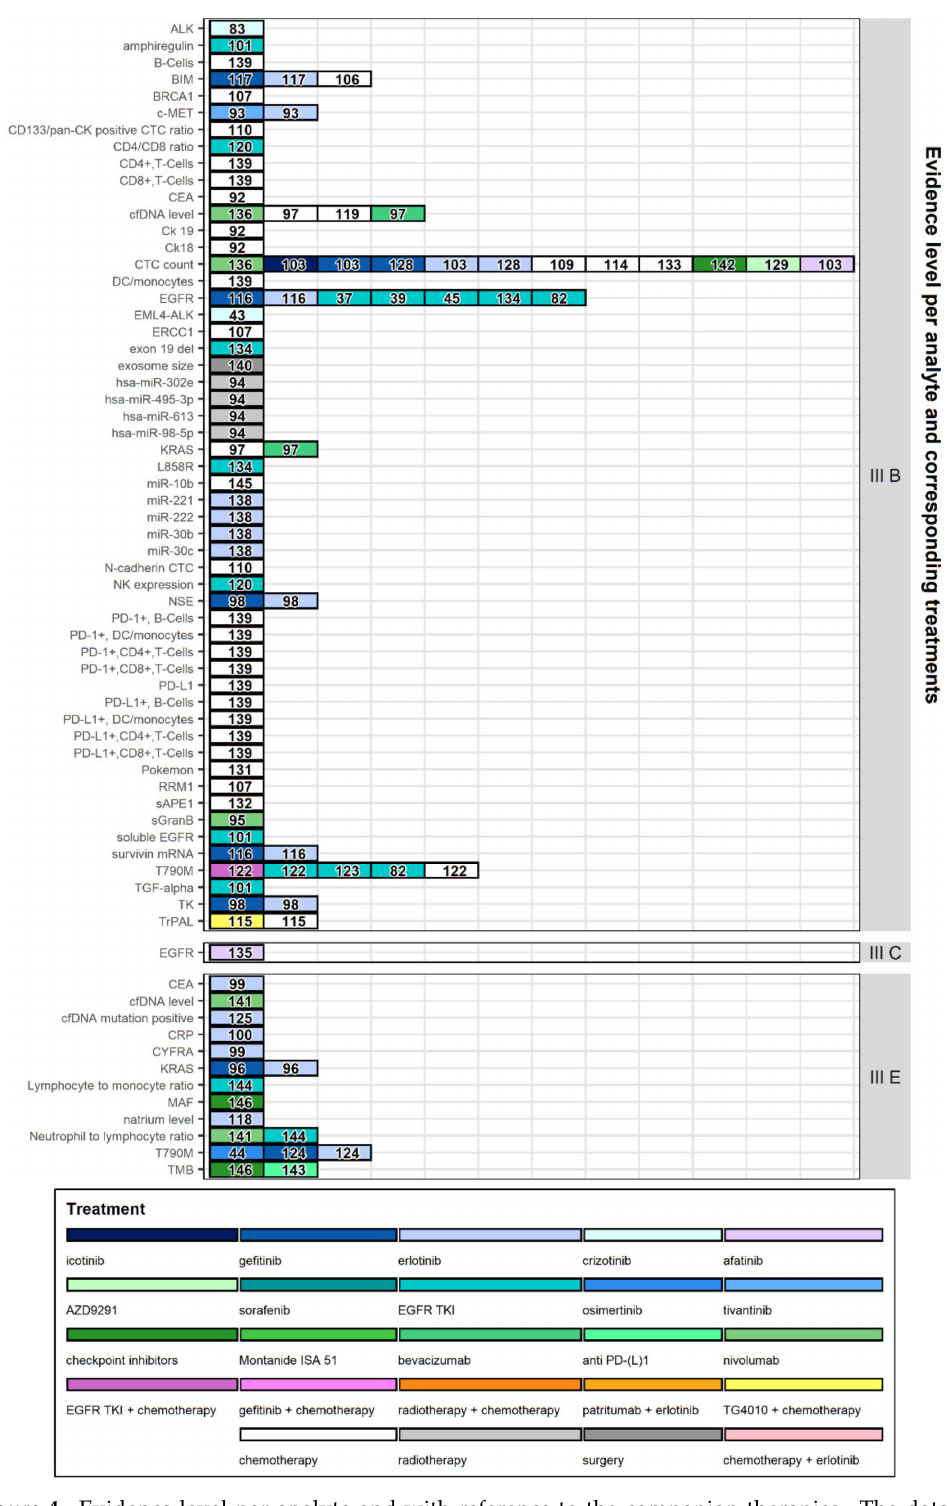
Figure 4. Evidence level per analyte and with reference to the companion therapies. The data is presented for each evidence level (levels I-III; right y-axis) and studies were categorized based on the biomarker of interest. Di ff erent colors are used to indicate the treatment these biomarkers were compared to and numbers within the bars refer to the corresponding reference number. The evidence levels were adopted from Rao et al. [147]. I D: Post-hoc biomarker correlative analysis of a